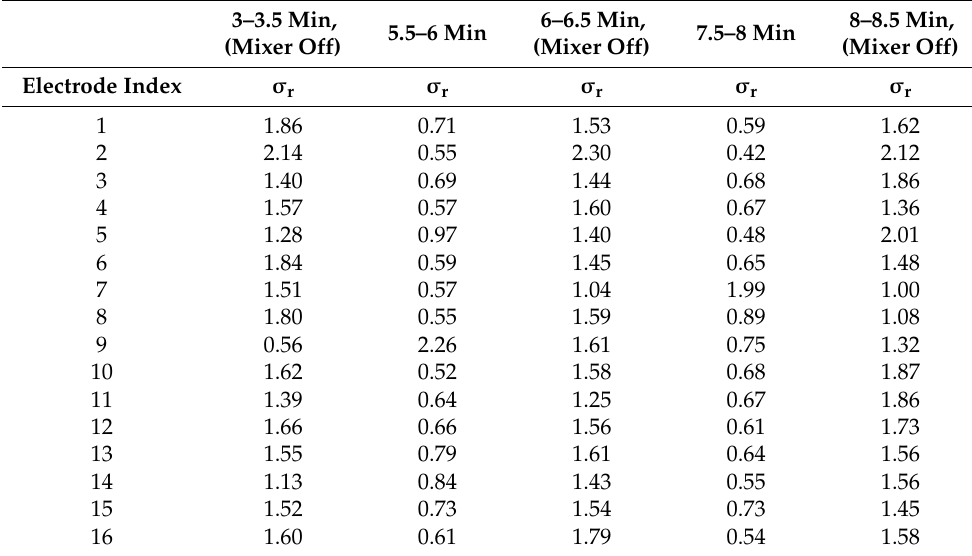
Table A1. Standard deviation ratio analysis of all the electrodes of the ERT system. SD ratio ( σ r ) are evaluated according to Equation (5) in the main text and are reported around the time that the mixer switches off. The results are related to the experiment where CaCl 2 concentration is 1.6 g L − 1 , without the feed solution addition; the mixer switches on at 100 RPM. Illustrations for selected electrodes are displayed in Figure 6 of the main